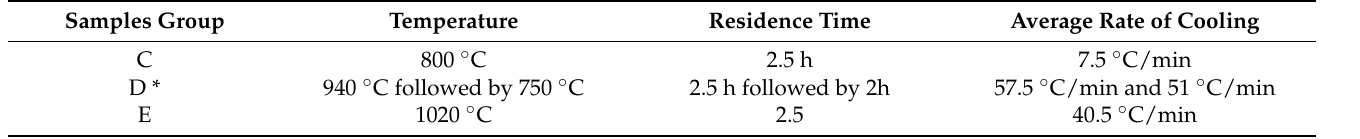
Table 2. The heat treatment cycles of different samples of LPBF Ti6Al4V(ELI). Samples